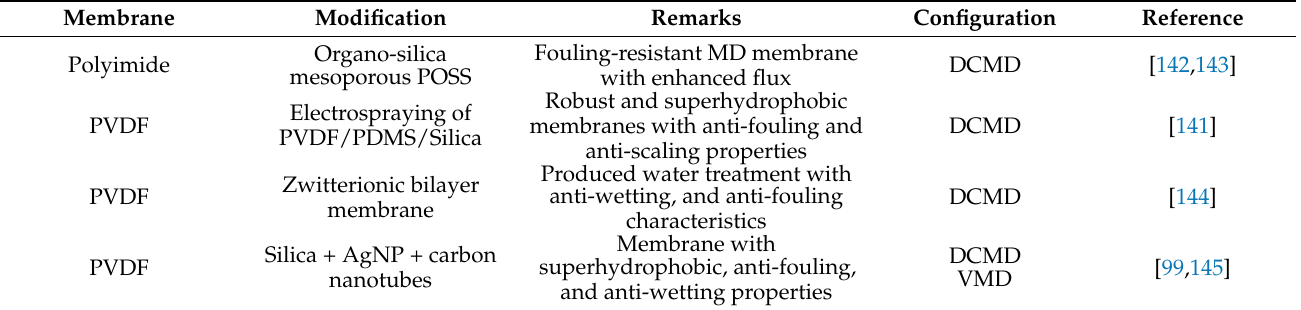
Table 5. Modification of electrospun membranes for gaining anti-fouling or anti-scaling